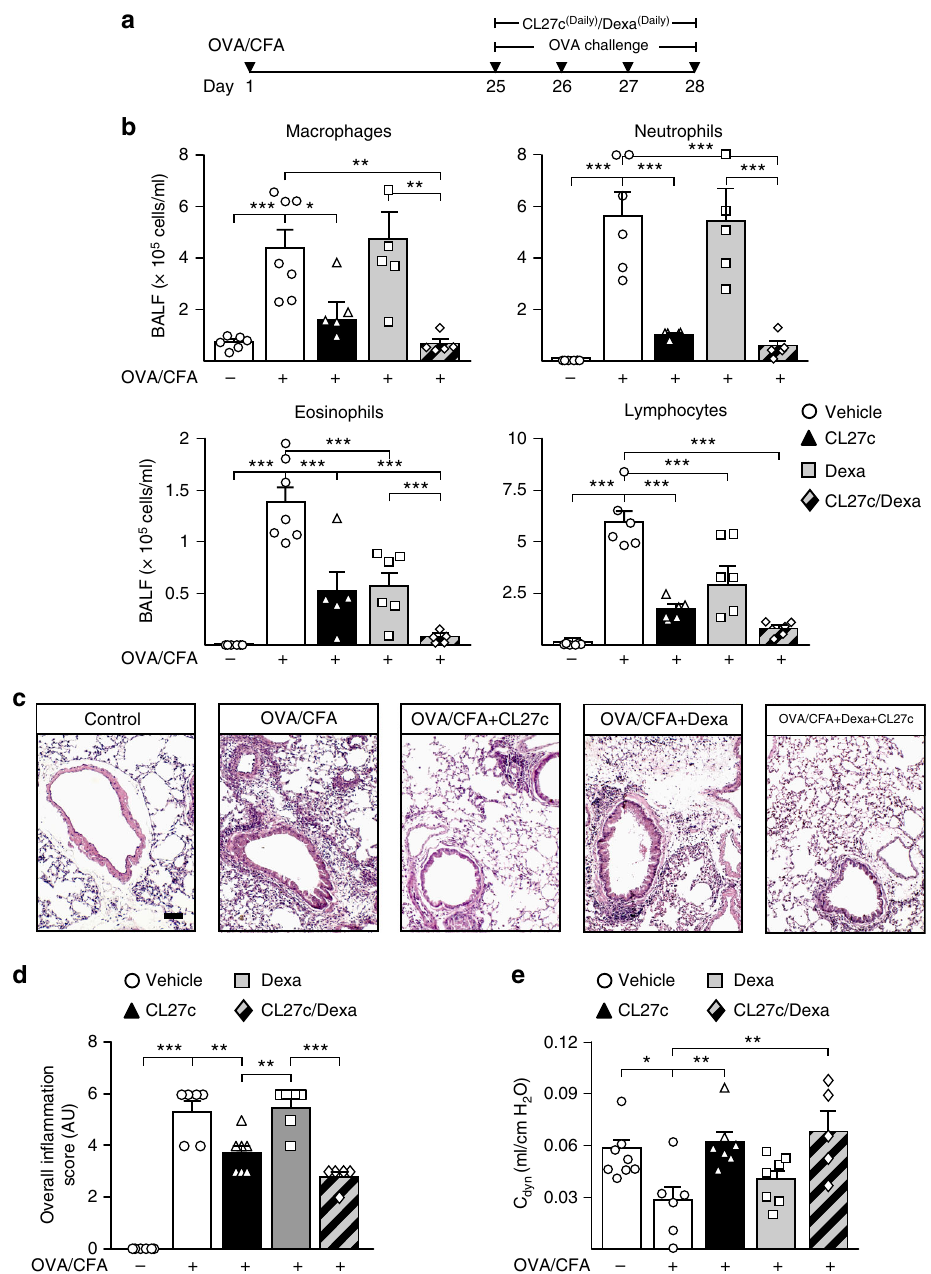
Fig. 5 Combination of CL27c and Dexamethasone reduces in fl ammatory injury and prevents loss of lung function in a mouse model of corticosteroid- resistant allergic asthma. a Protocol for corticosteroid-resistant allergic asthma and treatment regimen with aerosolized CL27c (2 mg/ml), Dexamethasone (Dexa, 5 mg/kg i.p.), or a combination of CL27c and Dexamethasone. b Quanti fi cation of different in fl ammatory cell populations in BALF of mice treated as in ( a ) (from left to right, macrophages n = 6, 7, 5, 5, 5, neutrophils n = 5, 6, 5, 5, 5, eosinophils n = 6, 7, 5, 6, 5, and lymphocytes n = 6, 6, 6, 6, 6 independent experiments, respectively). c Histopathological analysis of lung sections stained with hematoxylin and eosin. Treatment with CL27c reduces the in fl ammatory in fi ltrate (black arrowheads). d Histopathological changes in lung in fl ammation, scored as described in Methods, in control (OVA/CFA − ) and OVA/Complete Freund ’ s Adjuvant-treated (OVA/CFA + ) mice further receiving either CL27c, Dexamethasone (Dexa), or their combination (from left to right n = 6, 6, 7, 6, 5 independent experiments, respectively). e Analysis of dynamic pulmonary compliance (Cdyn) in control and asthmatic mice treated with either CL27c, Dexamethasone or their combination (from left to right n = 8, 6, 7, 7, 5 independent experiments, respectively). Results represent mean ± s.e.m., * P < 0.05, ** P < 0.01, *** P < 0.001 determined using one-way ANOVA followed by Bonferroni post-hoc test ( b , c ) and Kruskal – Wallis followed